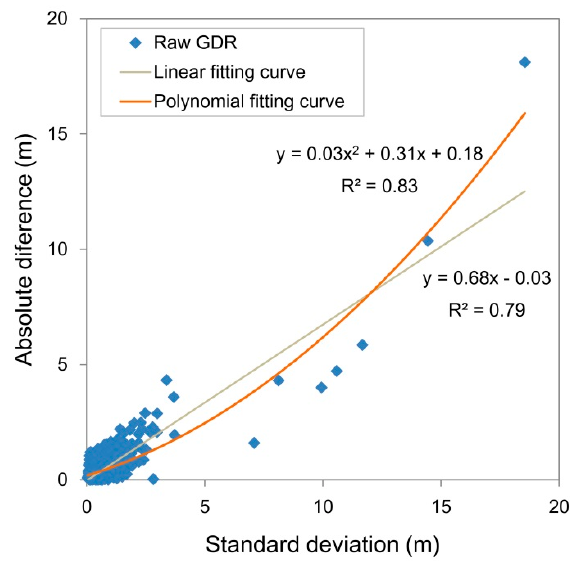
Figure 6. Scatter plot of the standard deviation for each along-track segment against the absolute difference of the raw GDR compared with in situ gauge measurements.